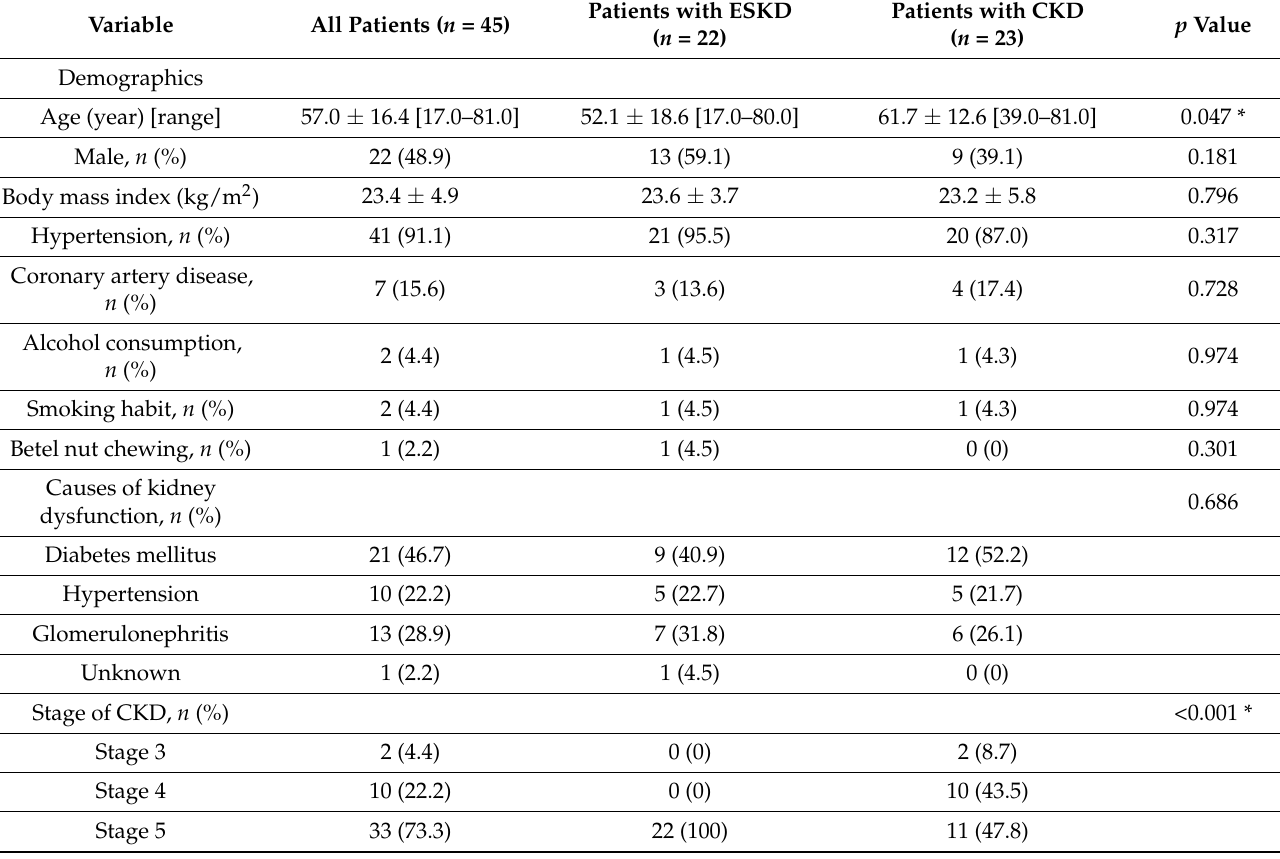
Table 3. Baseline characteristics of patients, stratified by renal function as ESKD or CKD ( n = 45). Variable